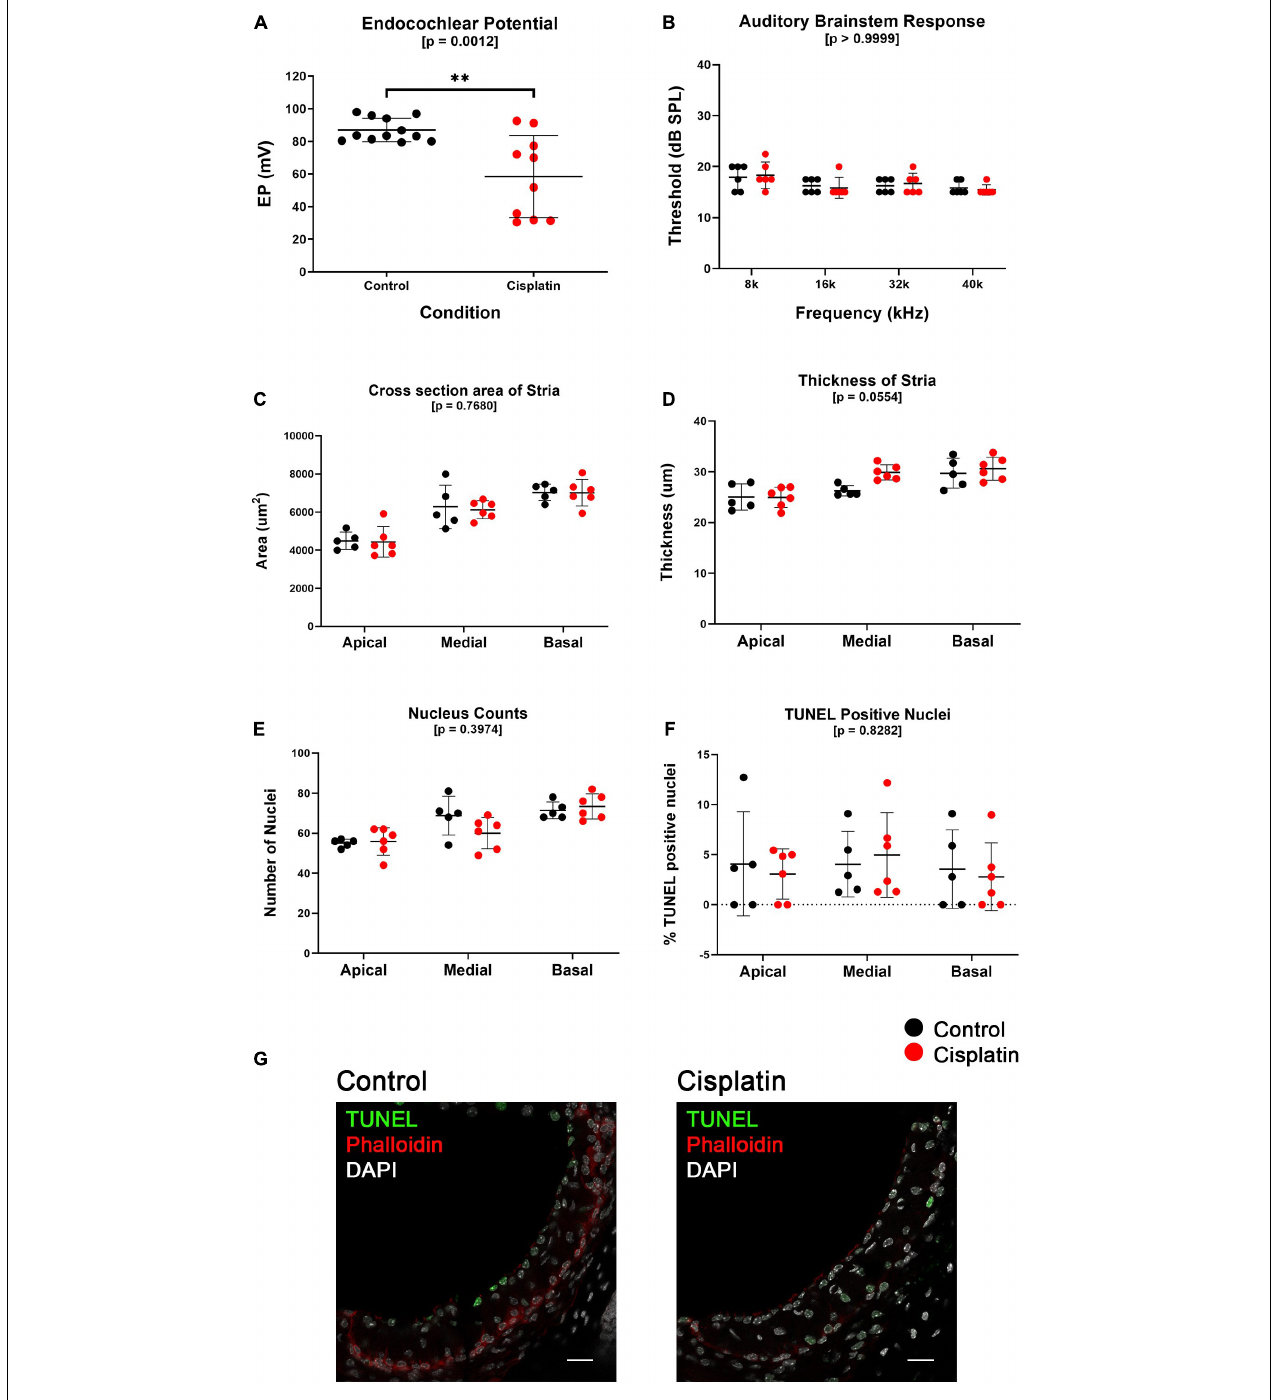
FIGURE 1 | A single dose of cisplatin (14 mg/kg, IP) results in a reduction in EP after 24 h with no reduction in ABR threshold, minimal structural change, and no evidence of increased apoptosis. (A) , EP measurements obtained 24 h after treatment in control ( n = 12) and cisplatin-treated ( n = 10) demonstrate that cisplatin-treated mice have a reduced EP compared to control mice ( p = 0.0012). (B) In a separate cohort of mice, ABR thresholds measured at the 8, 16, 32, and 40 kHz frequencies were unchanged between control ( n = 6) and cisplatin-treated ( n = 6) mice (two-way ANOVA, p > 0.9999). (C) SV cross-sectional area was unchanged between conditions in all cochlear turns (two-way ANOVA, p = 0.7680). (D) SV thickness was unchanged between conditions in all cochlear turns (two-way ANOVA, p = 0.0554). (E) Total nucleus counts in the SV were unchanged between conditions in all cochlear turns (two-way ANOVA, p = 0.3974). (F) TUNEL-positive cell nuclei, calculated as a percentage of the total nuclei, was unchanged between conditions in all cochlear turns (two-way ANOVA, p = 0.8282). (G) Representative TUNEL staining in SV cross-sections. For (B–G) , one cohort of mice were used, control ( n = 6) and cisplatin-treated ( n = 6). Scale bars: 20 µ m. ** p <